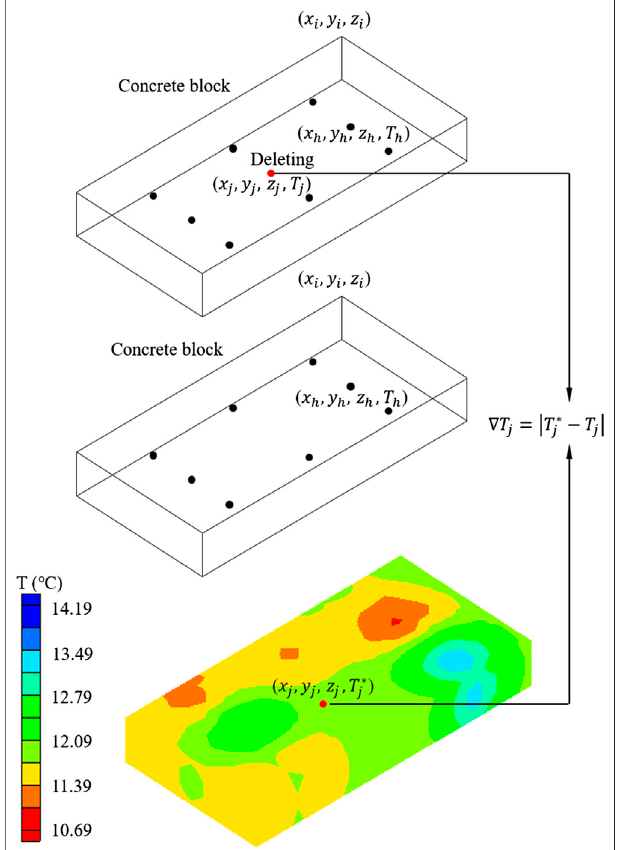
FIGURE 2 | Accuracy of the thermal fi eld judged by the cross-validation